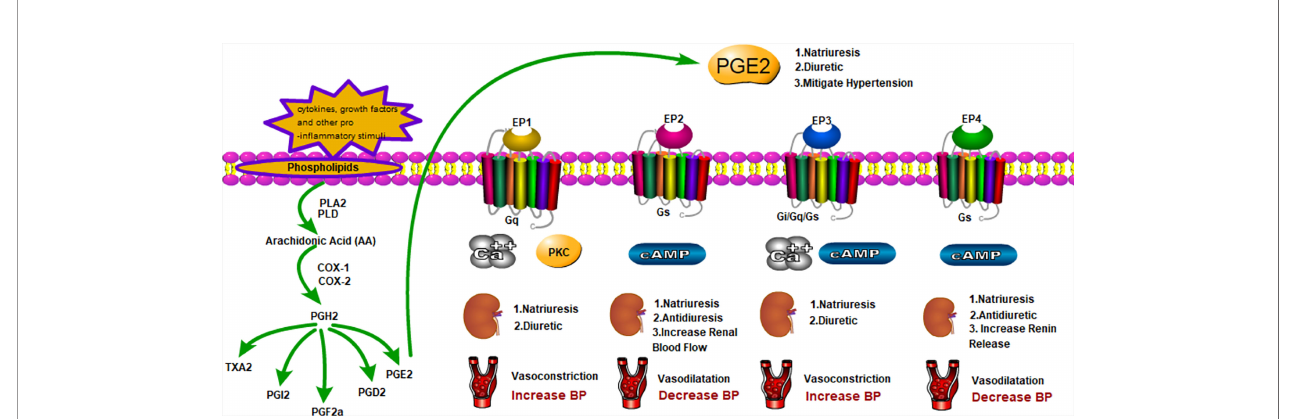
FIGURE 1 | Generation of PGE2 and Functions in Fluid Balance and Blood Pressure with The